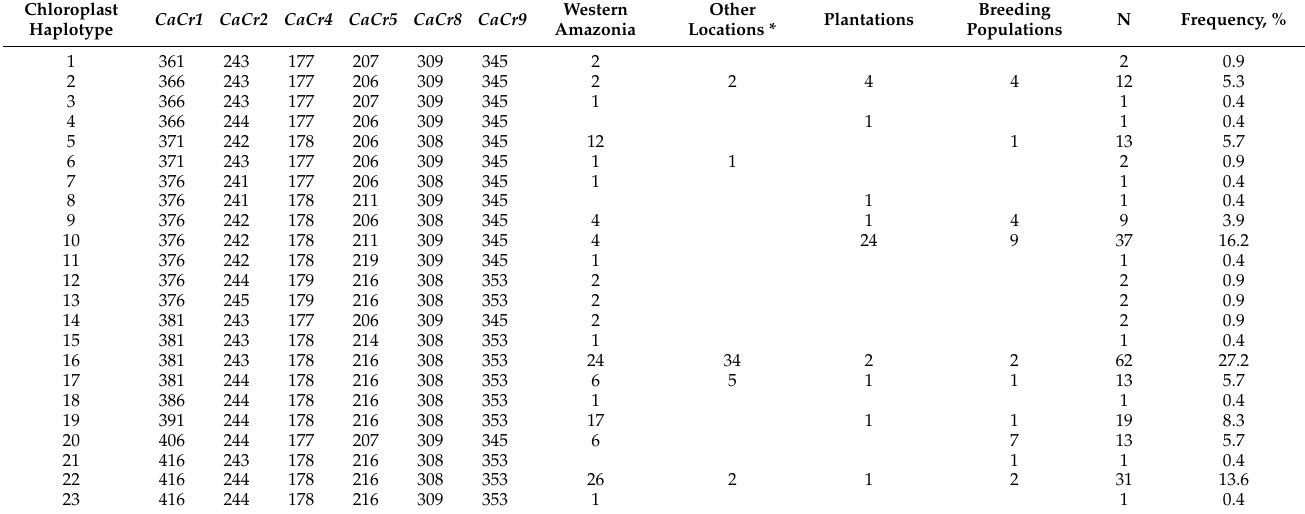
Table 1. Theobroma cacao L. chloroplast haplotypes and their frequencies observed in different locations in the Amazon, plantations, and breeding